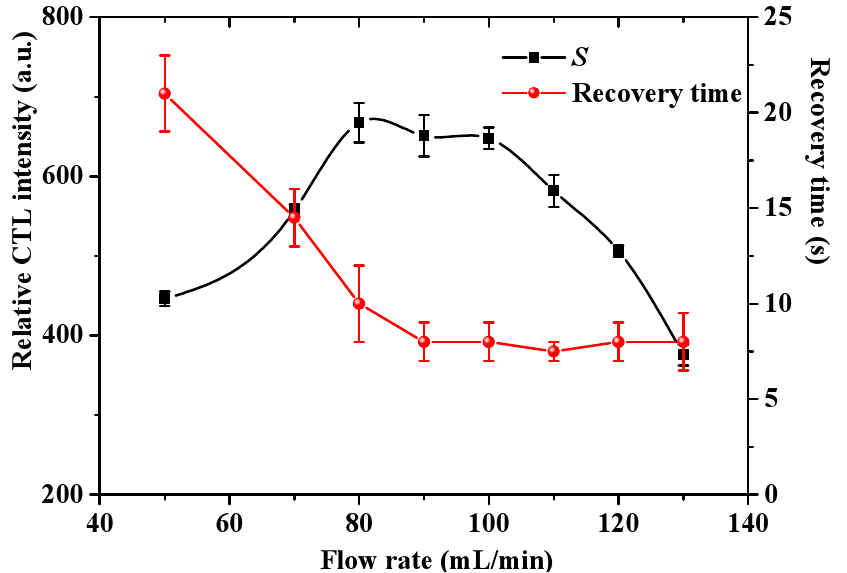
Figure 5. Effect of air flow rate on the relative CTL intensity and recovery time. Test conditions were: temperature: 200 °C, wavelength: 425 nm, concentration: 1.2 mg/L. Error bars stand for ± S.D.